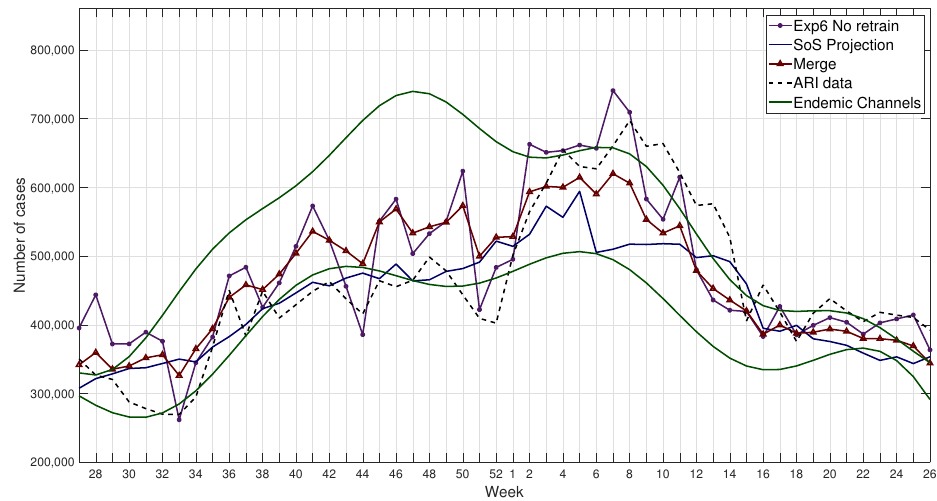
Figure A2. Results from the model for the year 2016–2017 compared with the real values for ARI cases.